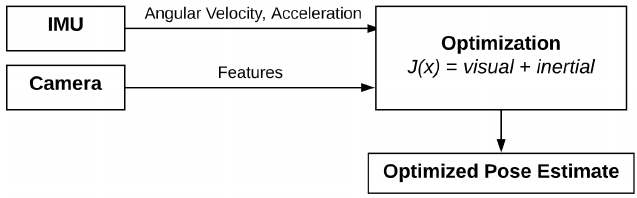
Figure 3. Tightly coupled sensor fusion